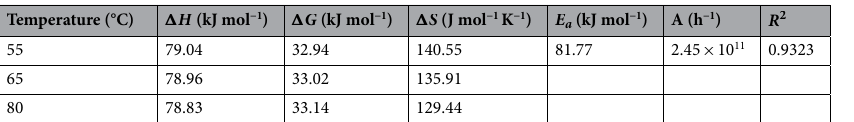
Table 4. Thermodynamic parameters for esterification of OA over 6TsOH-MBC